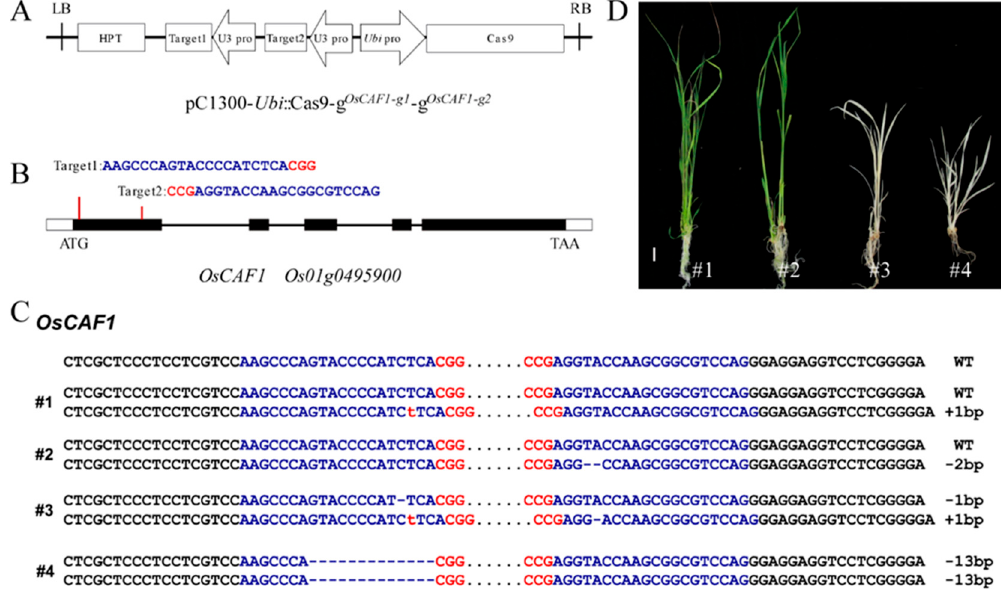
Figure 1. Knockout of OsCAF1 produces the albino phenotype in seedlings. ( A ) Diagram of CRISPR/Cas9 system for editing OsCAF1. ( B ) Schematic diagram of the targeted site in OsCAF1. ( C ) Mutation types of four positive plants in T 0 generation. The targeted sequences are in blue letters. The protospacer adjacent motif (PAM) sequences are in red letters. The number of nucleotides at both sides of the target sequences is 18 bp. ( D ) Phenotypes of four positive plants at seedling stage. Scale bar, 1 cm.